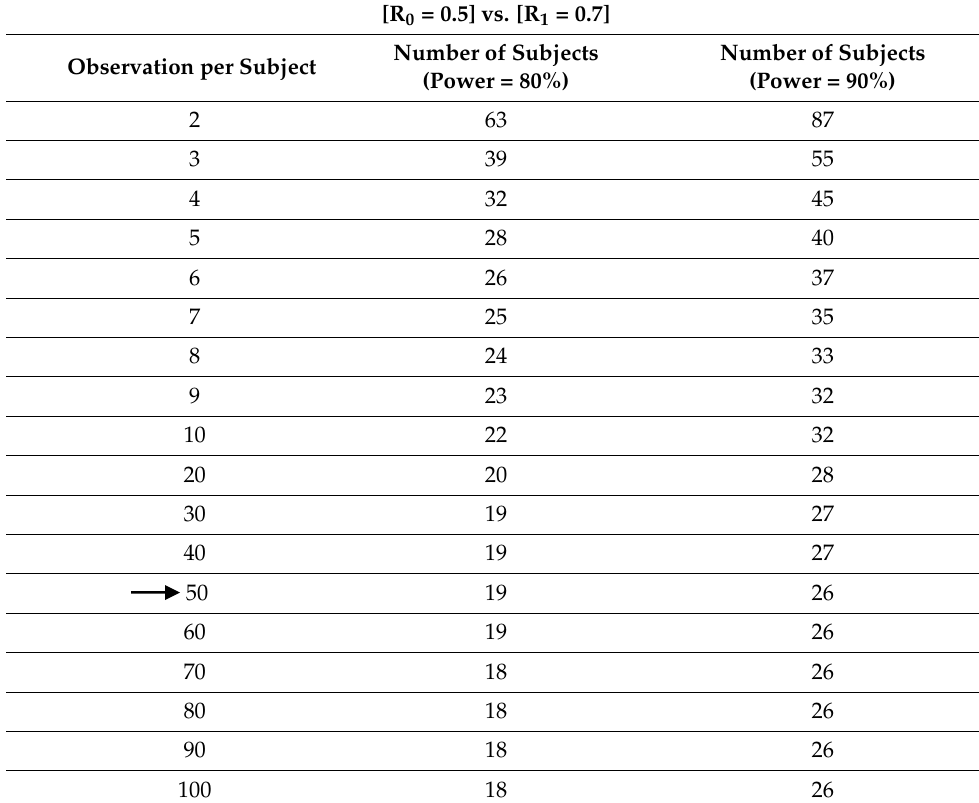
Table 1. Sample size requirement for intra-class correlation for R 0 (cid:54) = 0 versus R 1 (R 0 = 0.5 versus R 1 = 0.7) and alpha =